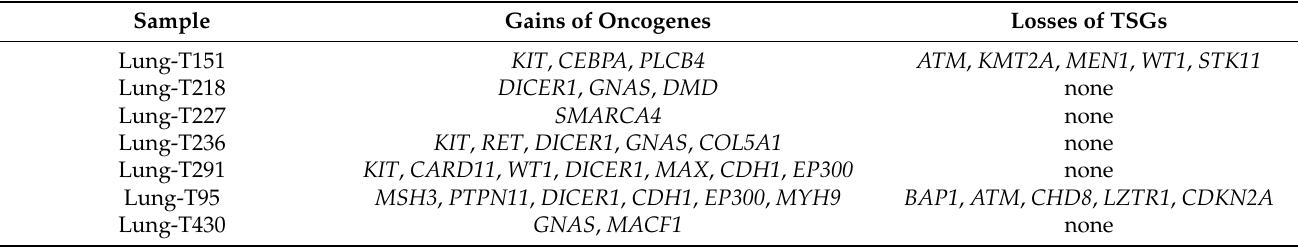
Table 2. Summary of gains of oncogenes and losses of TSGs (tumor suppressor genes) in seven NSCLC patients. Sample